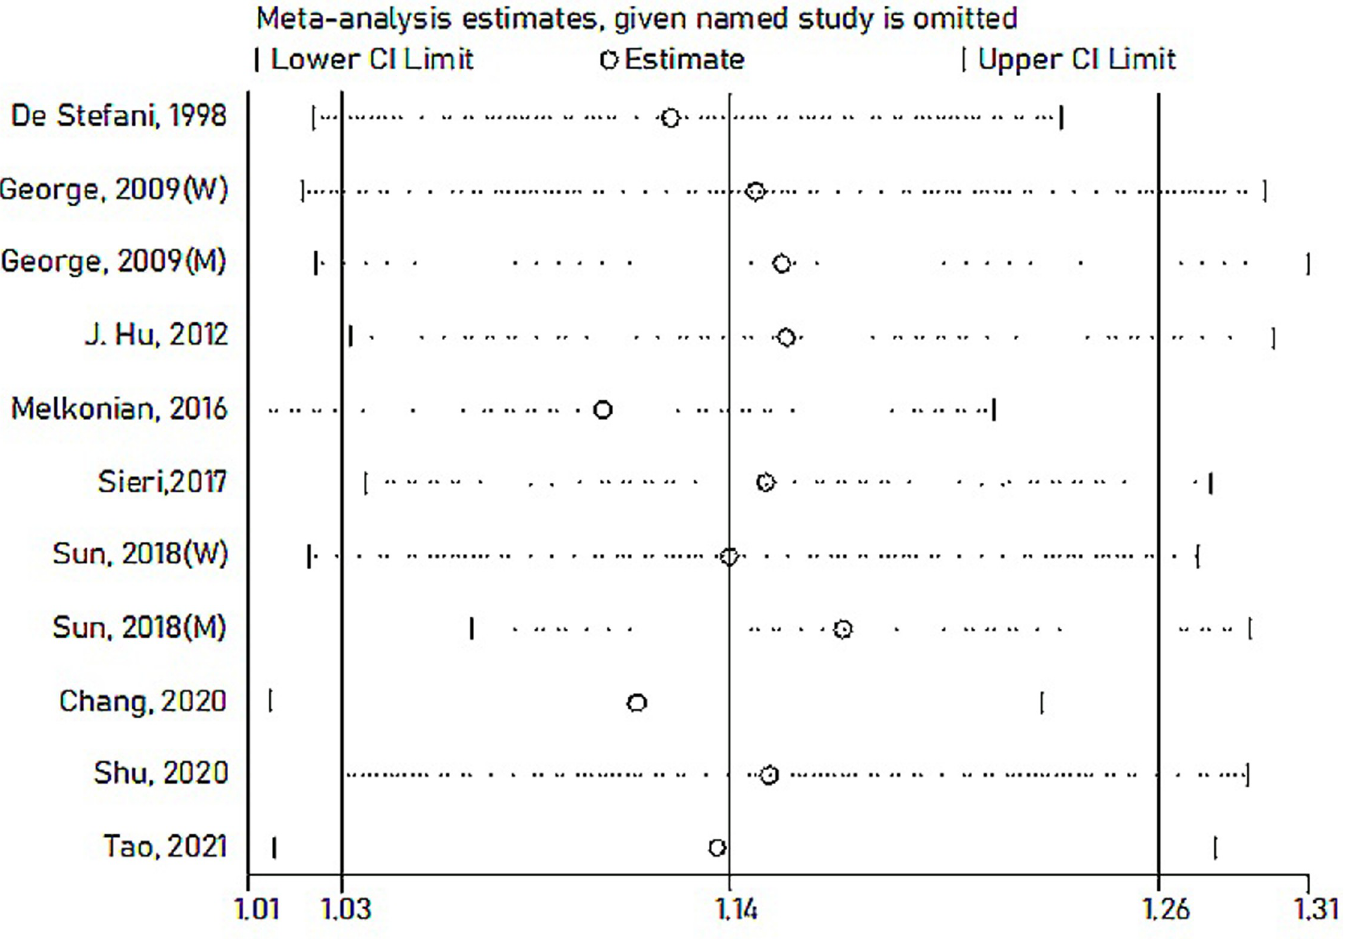
Fig 4. Sensitivity analysis for the association between GI and lung